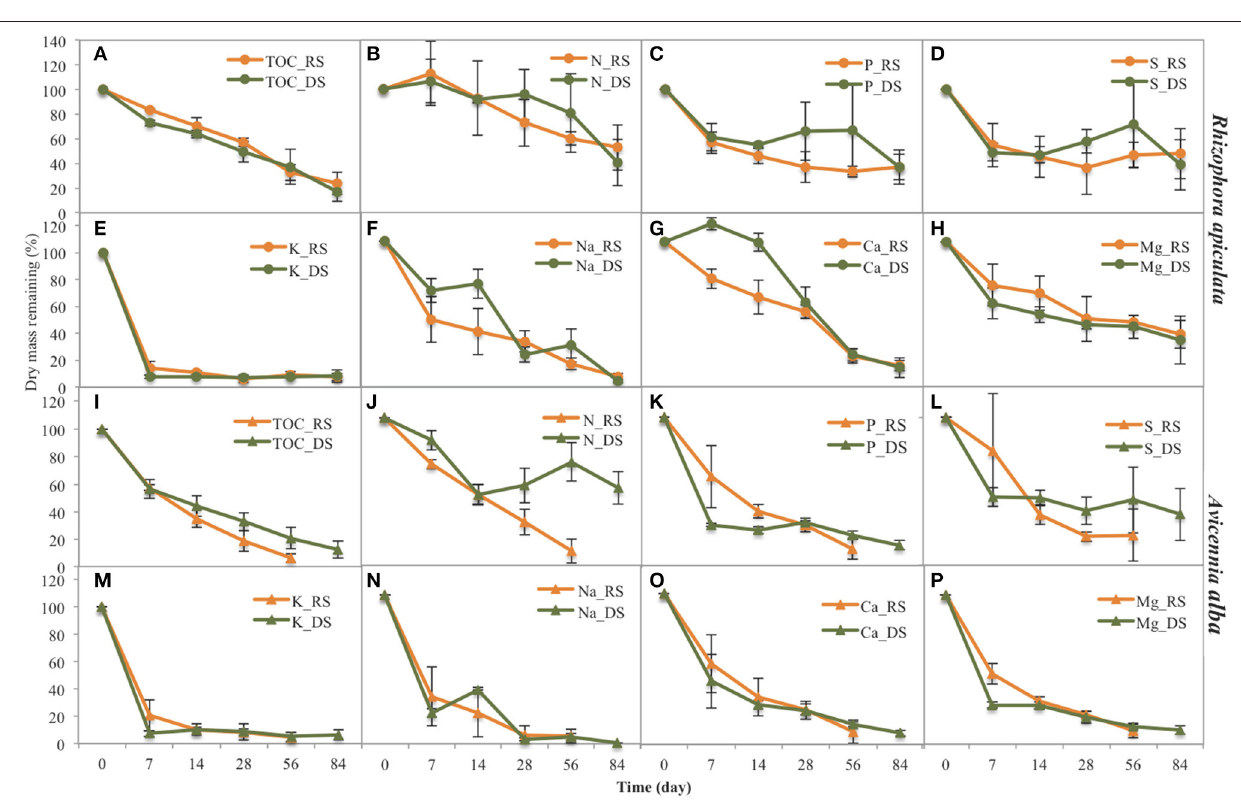
Frontiers in Environmental Science | www.frontiersin.org